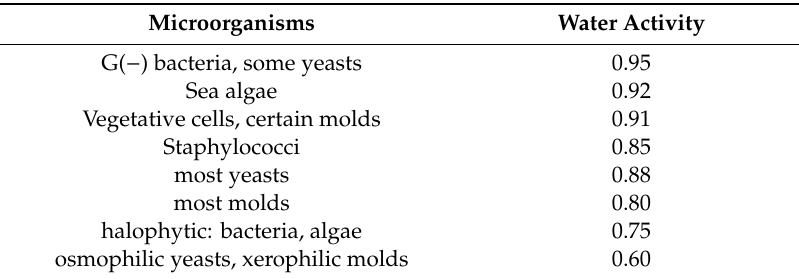
Table 1. Minimum water activity value for di ff erent microorganisms [10].